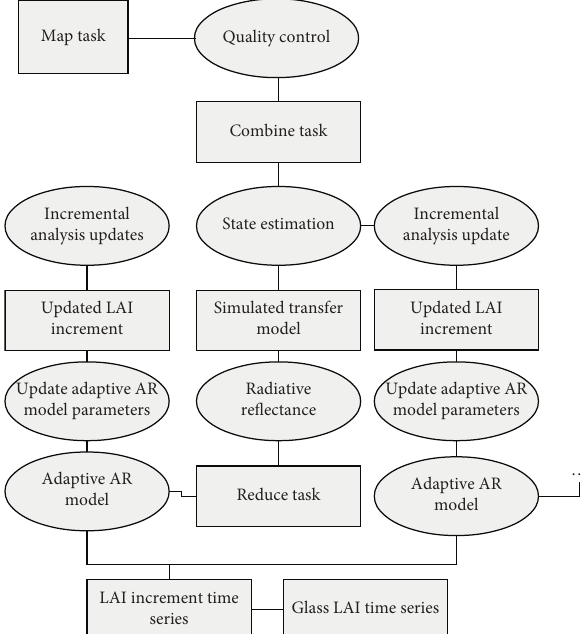
Figure 3: Design flow of population collaborative intelligent clustering algorithm for cloud computing data center.